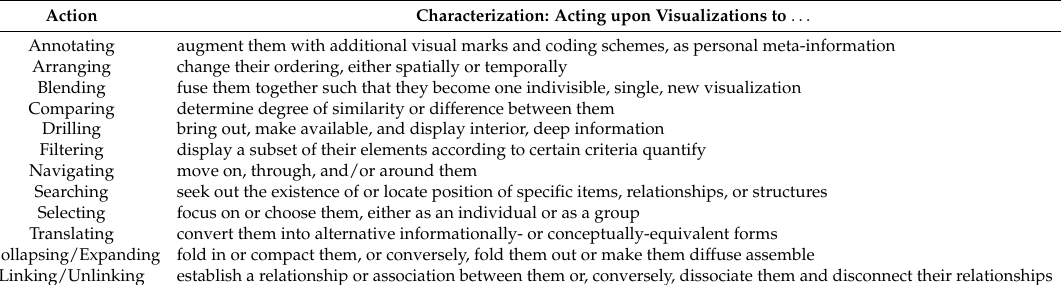
Table 1. Some of the epistemic actions from